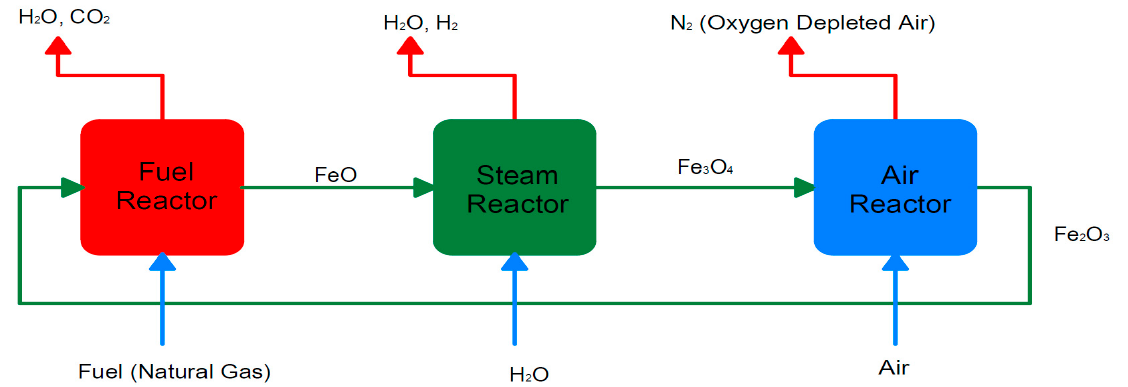
Figure 9. Conceptual design of three-reactors chemical looping for H 2 generation (adapted from [88]).